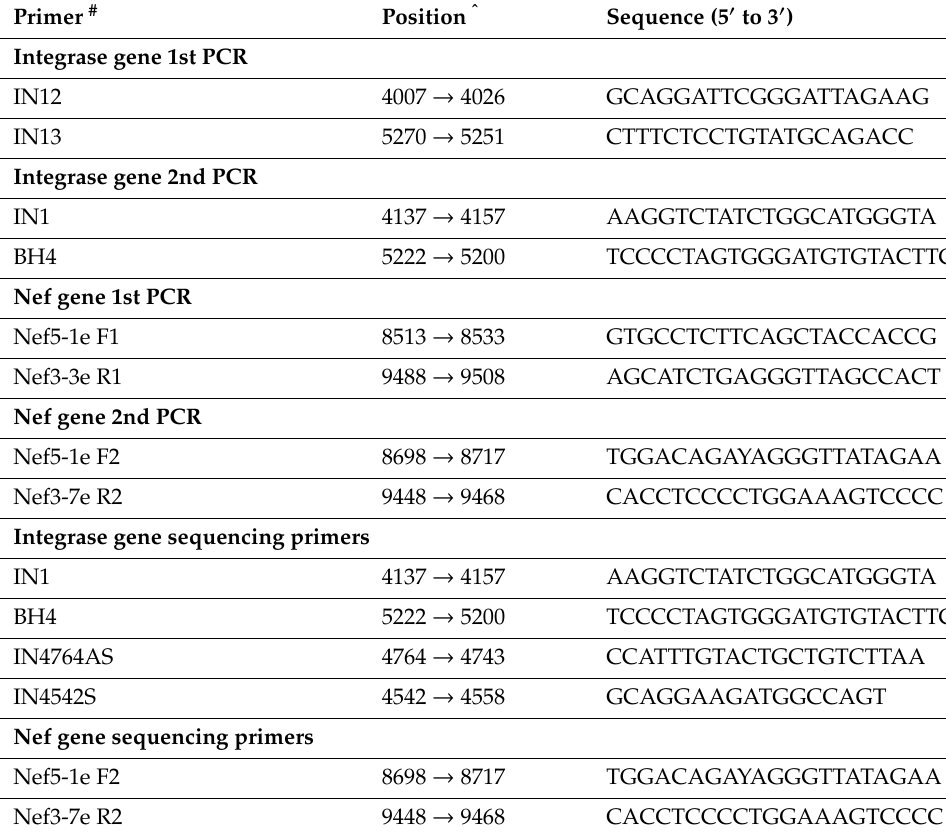
Table 6. Primers used for amplification and sequencing of integrase and nef genes